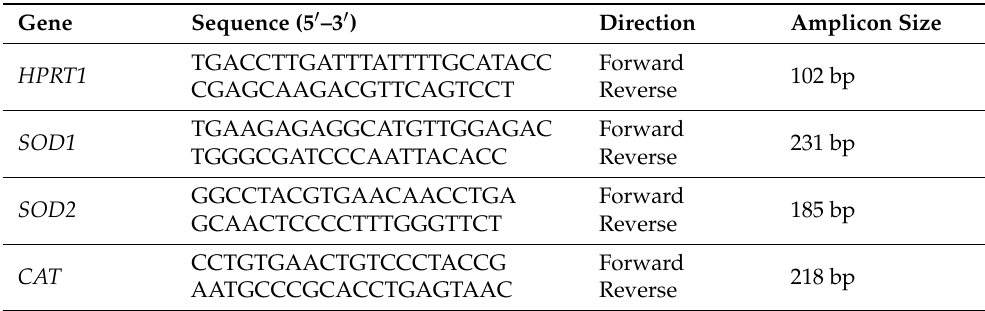
Table 1. Sequences of sense (S) and anti-sense (AS)-specific oligonucleotide primers and predicted PCR product sizes. Primers were designed to be